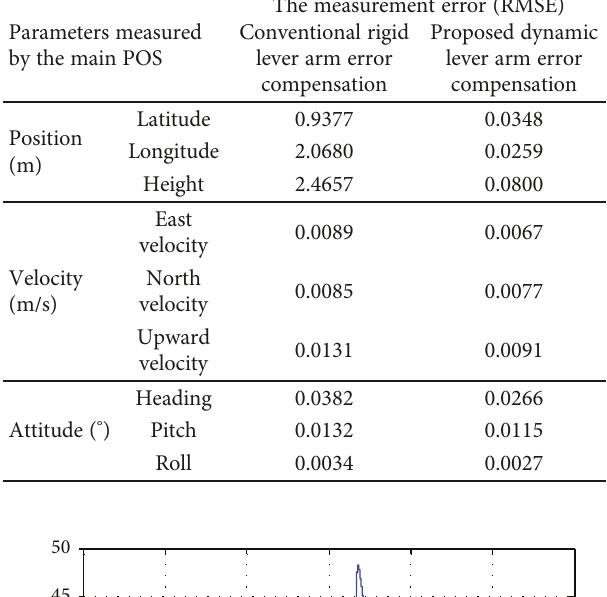
Table 3: Measurement error comparison of the fi rst-level dynamic lever arm error compensation.